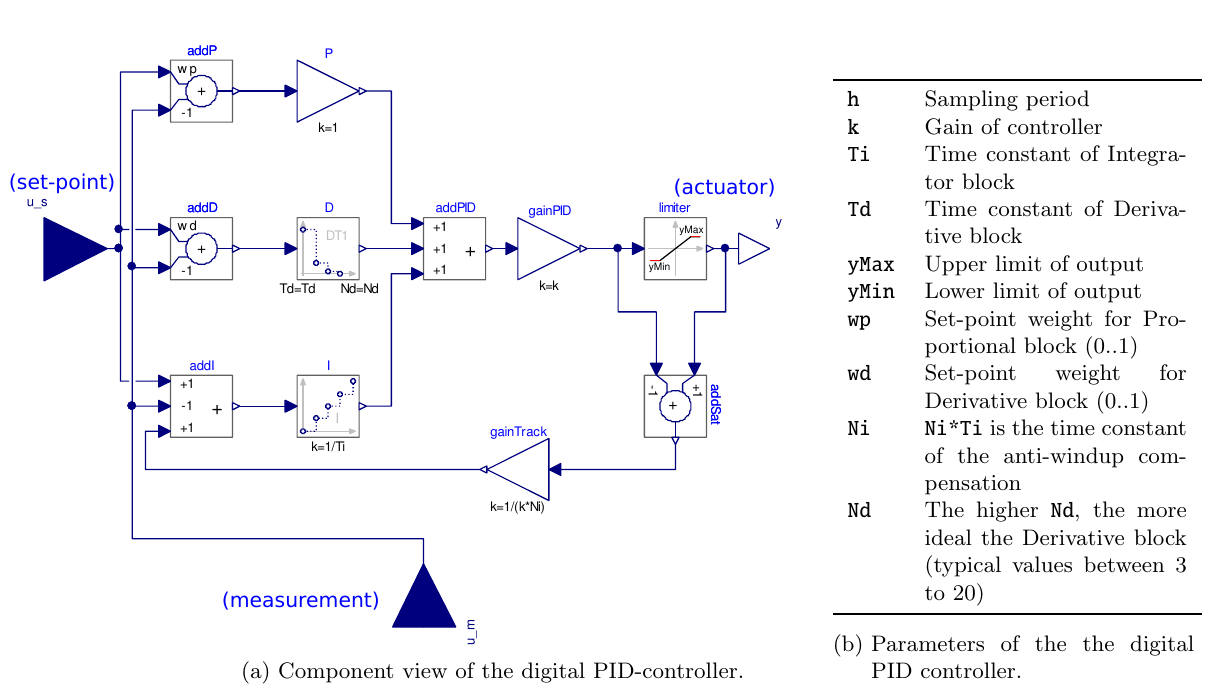
Figure 8: Digital PID controller with limited output, anti-windup compensation and set-point weighting.